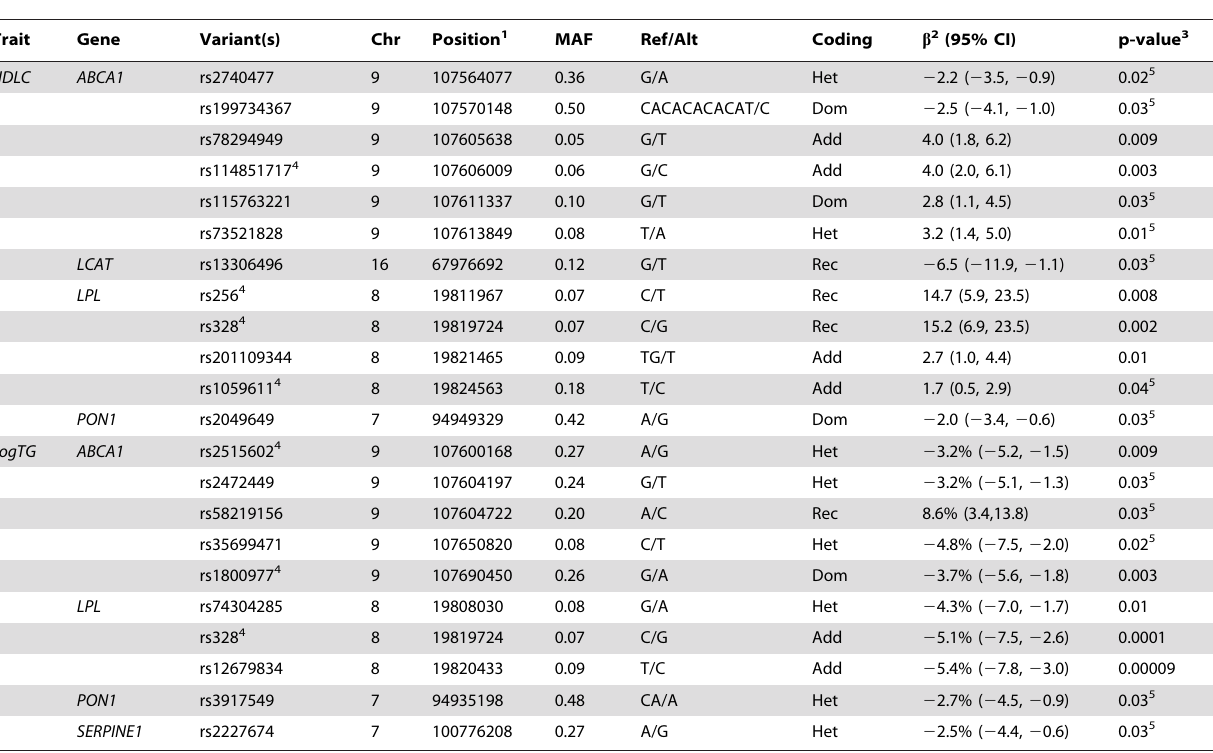
Table 2. Common variants in candidate genes associated with serum lipids in African Americans (n =1694).